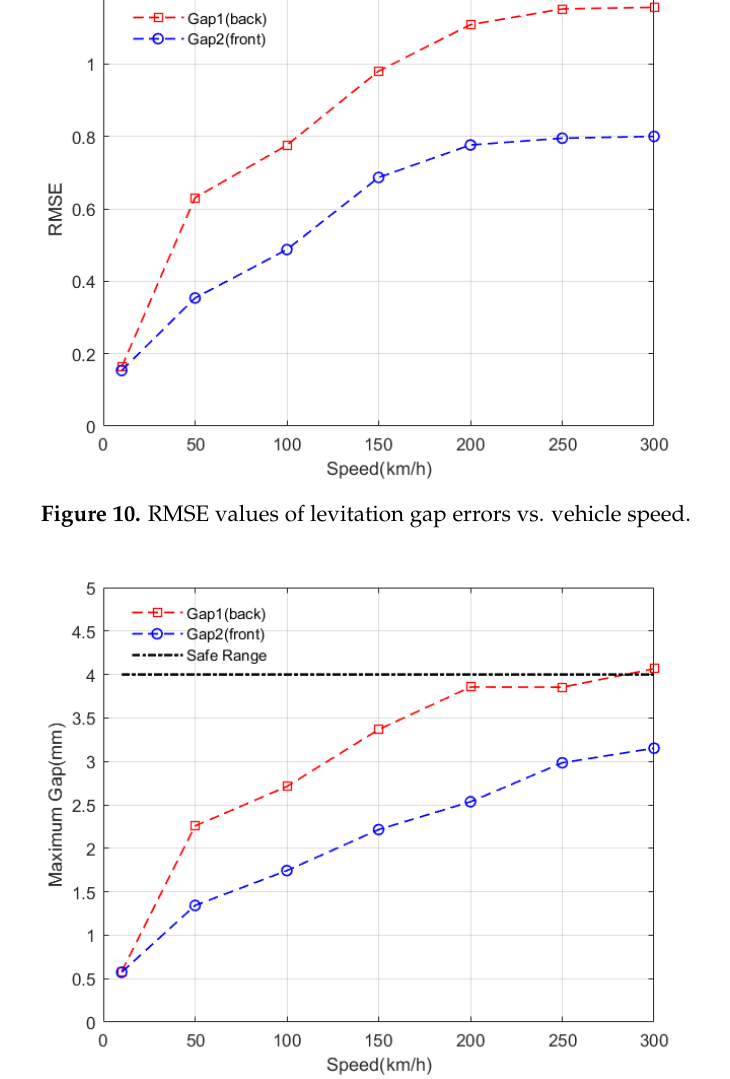
Figure 11. Maximum values of levitation gap errors vs. vehicle